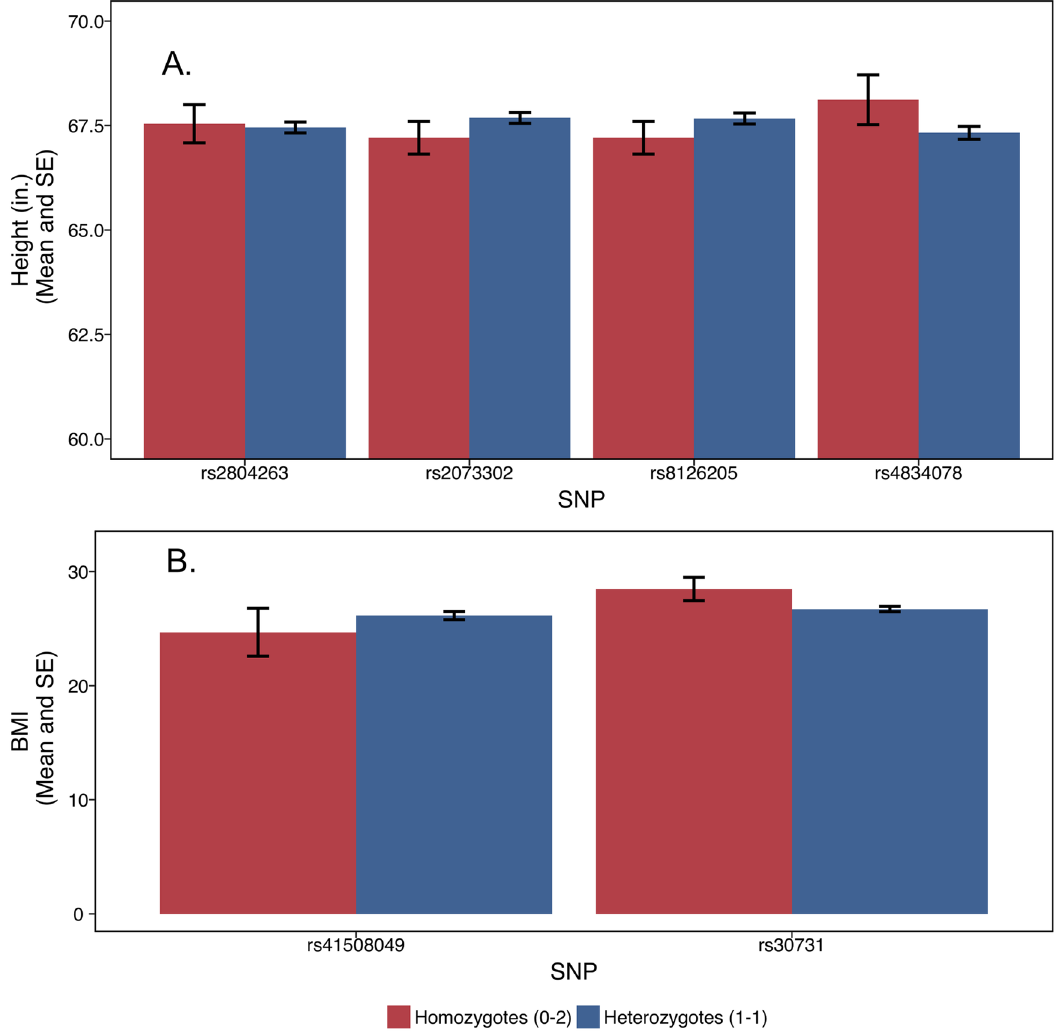
Fig 5. Test for spurious association with variance due to non-linear effects on mean levels. Mean and standard error for height (inches) and BMI among with two minor alleles is shown separately for homozygotes (one sibling with zero minor alleles and the other sibling with two) and heterozygotes (each sibling has one minor allele), for each genome-wide suggestively significant SNP for the respective trait ( A . height; B . BMI). One significant SNP for height (rs8029740) is not depicted because there is only one sibling pair with the 1-1 allele combination and 0 sibling pairs with the 0-2 combination. A two-sample t-test for equality of means, estimated separately for each SNP, revealed no significant differences between the two groups for the top hits for each